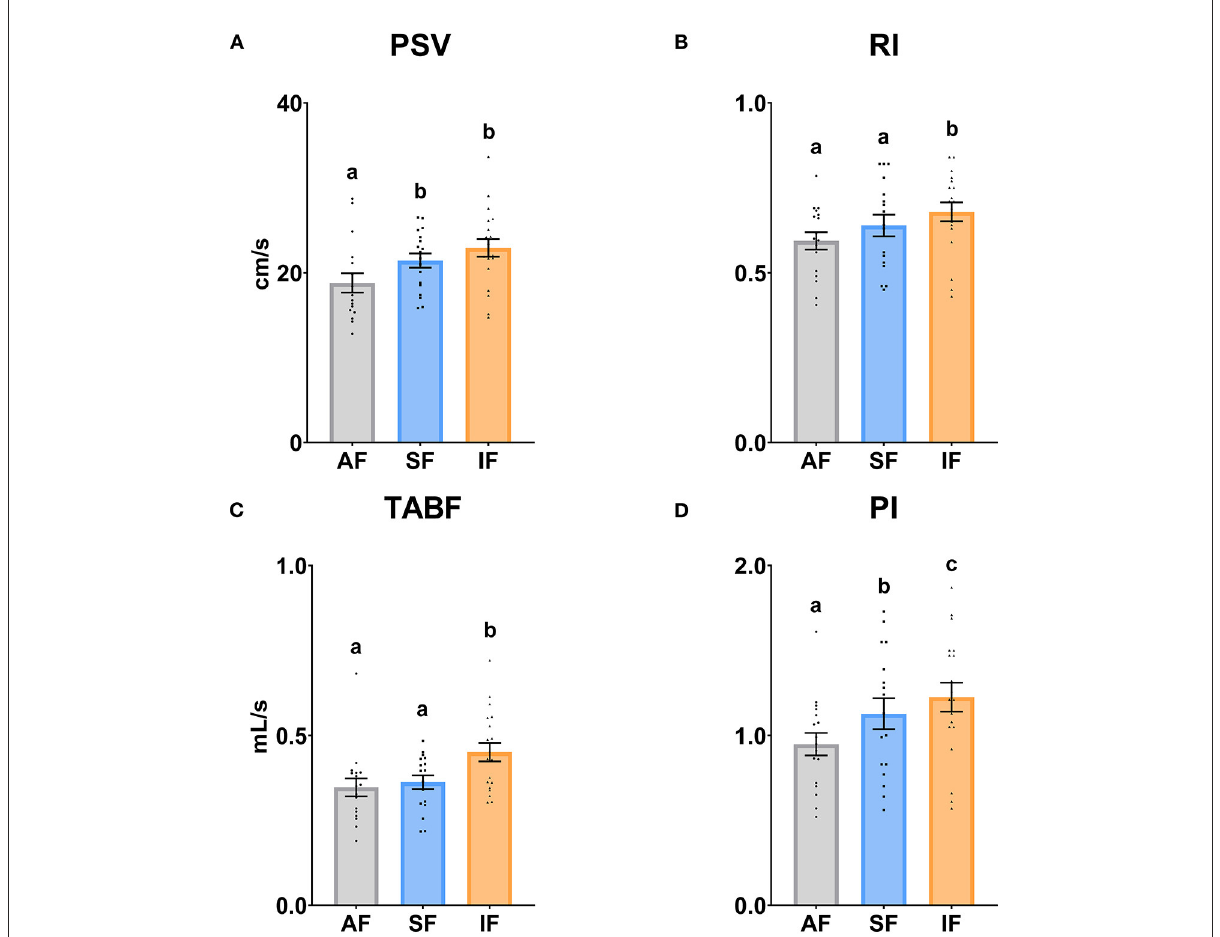
FIGURE4 Ram supratesticular artery Doppler parameters according to semen collection frequencies. (A) PSV, peak systolic velocity (cm/s); (B) RI, resistive index; (C) TABF, total artery blood flow (ml/min); (D) PI, pulsatility index. The same 17 males were analyzed in each experimental group (AF, abstinence semen collection frequency; SF, standard semen collection frequency; IF, intensive semen collection frequency). Graph dots represent individual male values. Means ( ± SEM) are shown. Different lowercase superscripts letters (a–c) indicate differences ( P ≤ 0.05) among the semen collection